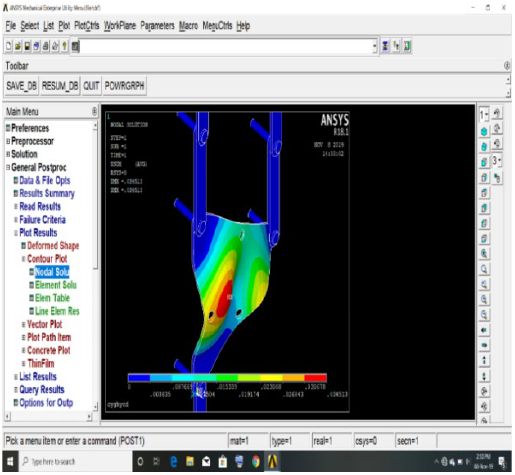
Figure 3. A top view of the Prototype